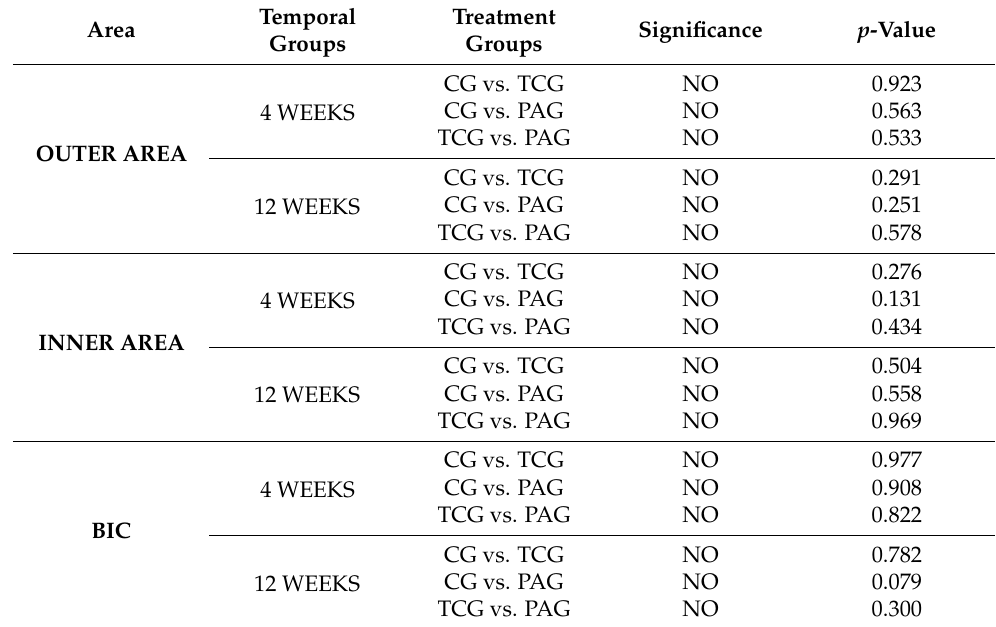
Table 2. Overall comparative statistical table of